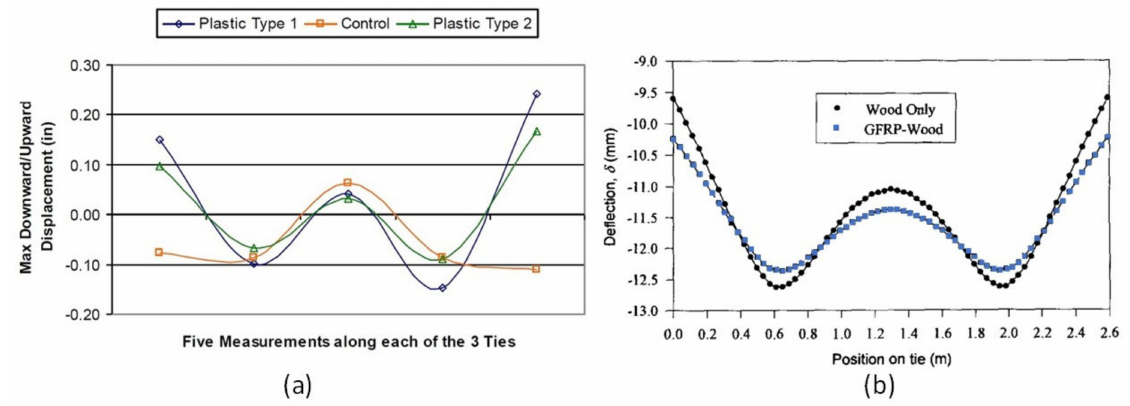
Figure 3. ( a ) In − service bending shape of plastic and timber sleepers [43]. ( b ) Deflection profile of timber with and without reinforcement according to BOEF